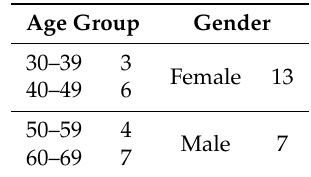
Table 1. Demographics of enrolled